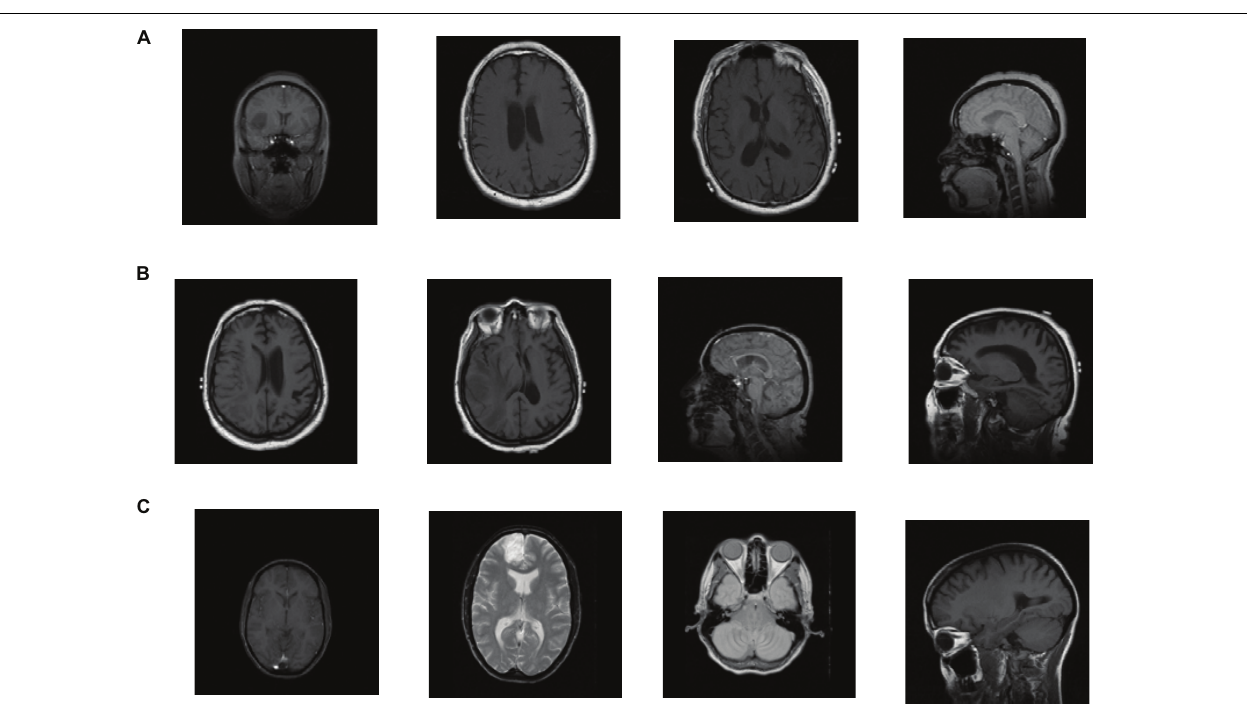
The model is an extension of traditional dictionary